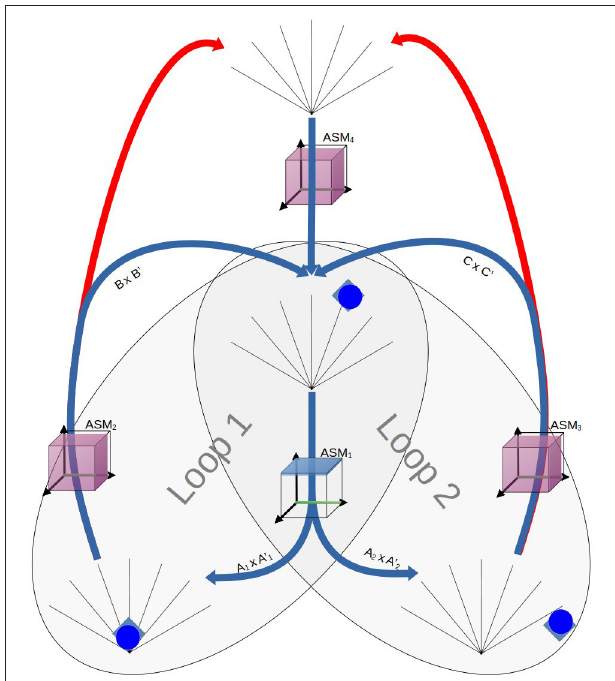
FIGURE 17 | An illustration of the robot’s arrangement of sensorimotor coordinations as they relate to the ASM-network. Successful performance of the task aligns with the robot proceeding through performance of Loops 1 and 2 without disruption. Over time ASM 1 develops such that only Transition 3 occurs when diamonds are present and only Transition 2 occurs when circles are present. Some simple adaptive processes also need to take place in ASM 2 and ASM 3 such that they consistently lead to the robot re-discovering the object as it returns into view. Note that ASM 5 does not feature as its only purpose in the network is to provide suitable initial conditions for ASM 4